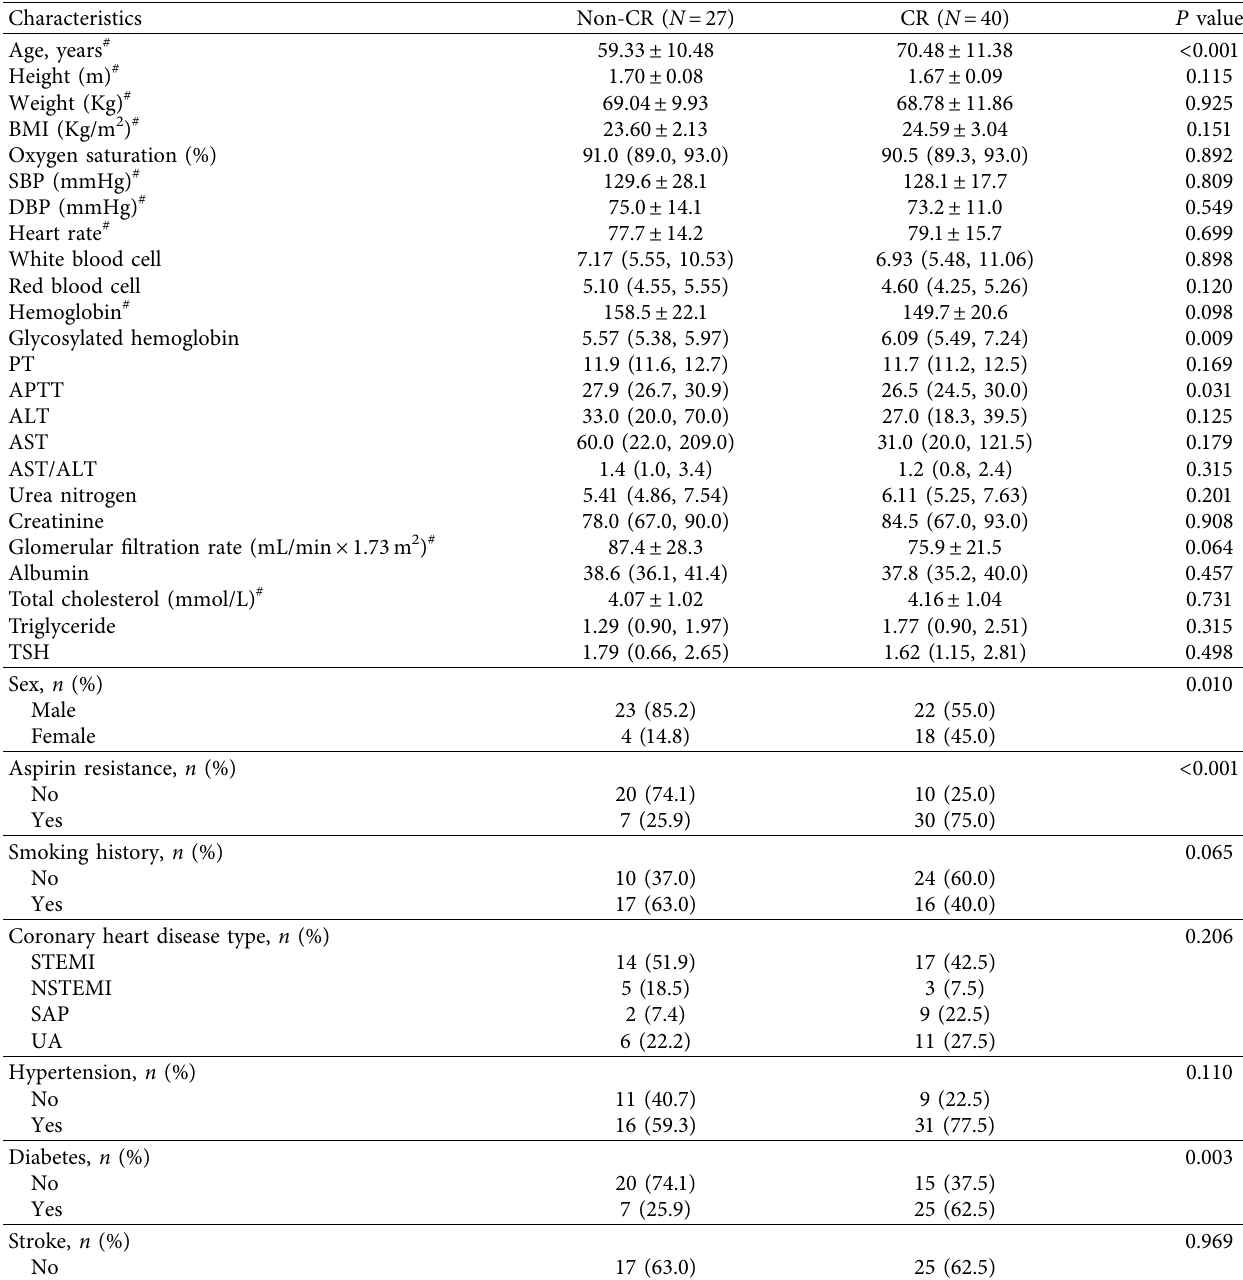
Table 3: Comparison of differences in baseline information between CR and non-CR for Han populations.